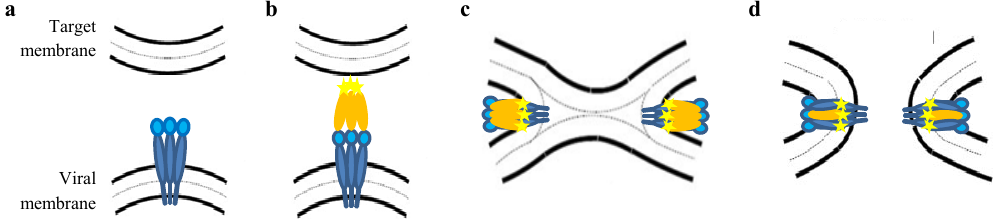
Figure 1. Membrane fusion of bovine leukemia virus (BLV) envelope protein based on the Murine Leukemia virus fusion model. ( a ) Fusion incompentent state of the envelope complex formed by the receptor-binding (surface protein (SU), gp51 in light blue) and the fusion (transmembrane protein (TM), gp30 in dark blue) subunits; ( b ) After receptor binding, a conformational change exposes the fusion peptide (yellow star) to the target cell membrane; ( c ) Insertion of the fusion peptide into the lipid bilayer mediates formation of a hemifusion diaphragm and blending of viral and cellular lipids (gray dots); ( d ) Fusion structure after refolding. In this state the fusion peptide and the TM are anchored into the same membrane in an anti-parallel conformation.